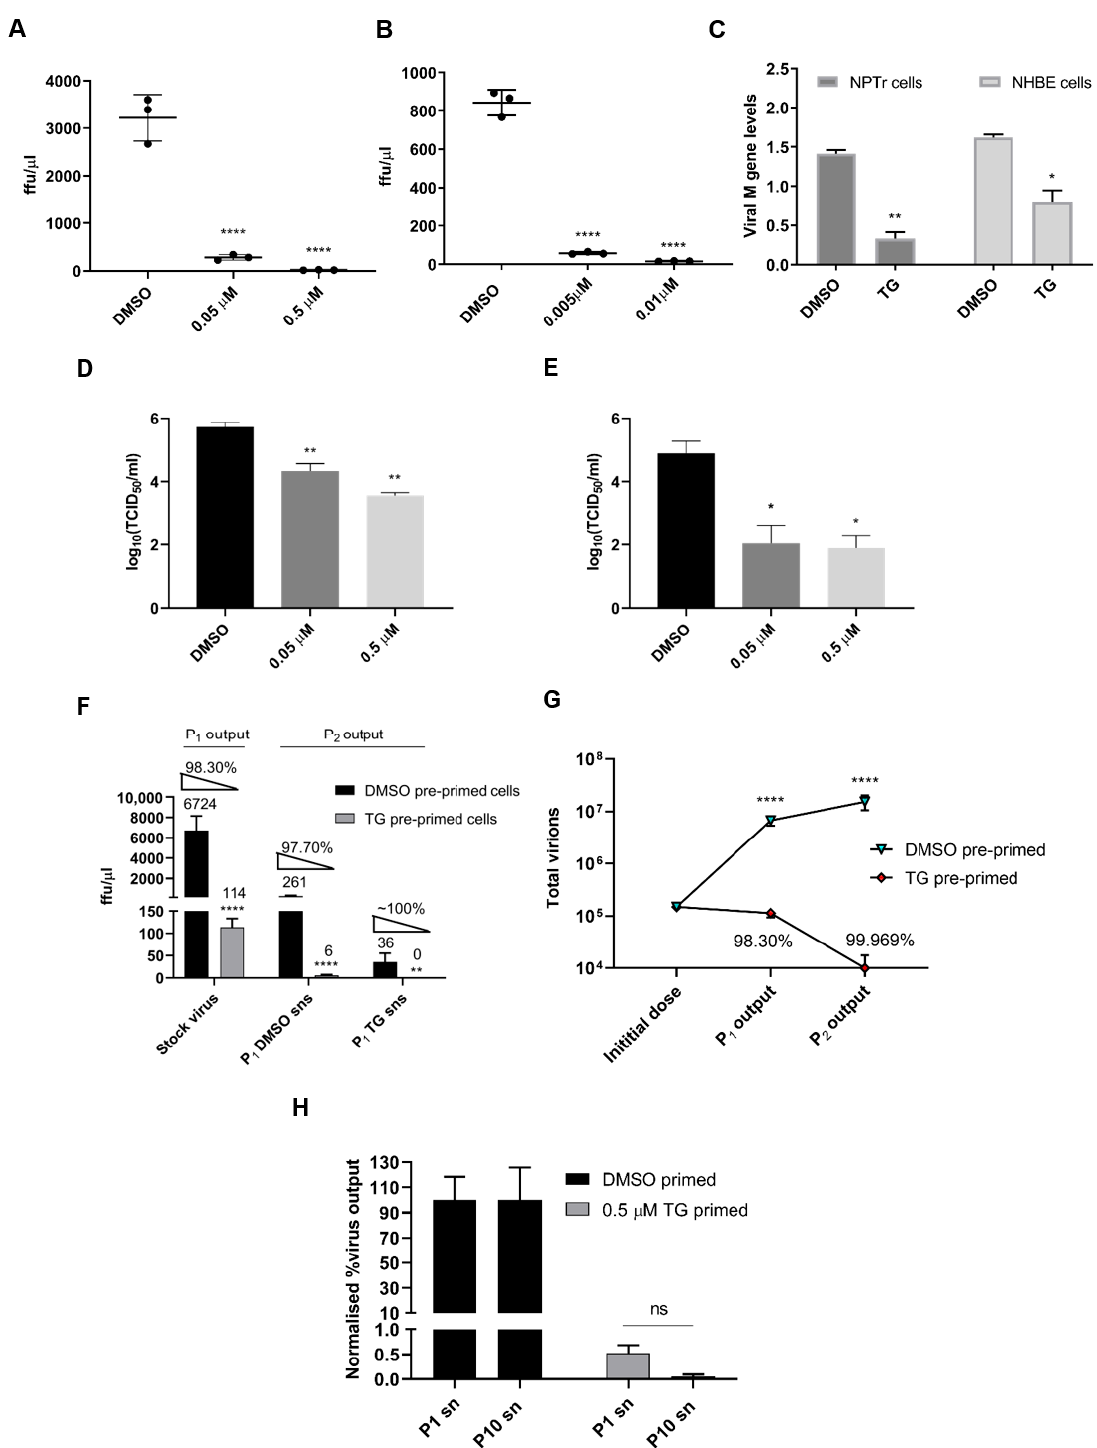
Figure 1. Brief TG priming of NPTr and NHBE cells blocks progeny influenza virus production. ( A ) NPTr cells and ( B ) NHBE cells were incubated for 30 min with TG or DMSO control at the indicated concentrations, PBS washed and infected for 12 and 24 h, respectively, with USSR H1N1 virus at 0.5 MOI. Spun supernatants (sns) were used to infect MDCK cells for 6 h in FFAs. Significance determined by one-way ANOVA, relative to DMSO control. ( C ) NPTr cells and NHBE cells were primed with TG (0.5 and 0.01 µM, respectively) or DMSO for 30 min, and infected with USSR H1N1 virus (0.5 and 1.0 MOI, respectively) for 24 h. Culture media were then harvested to determine presence of viral M-gene RNA. Significance determined by paired t-test. ( D , E ) MDCK cells were incubated for 30 min with TG or DMSO control at the indicated concentrations, PBS washed and infected for 24 h with ( D ) equine H3N8 and ( E ) canine H3N8 virus. TCID50 assay was performed to